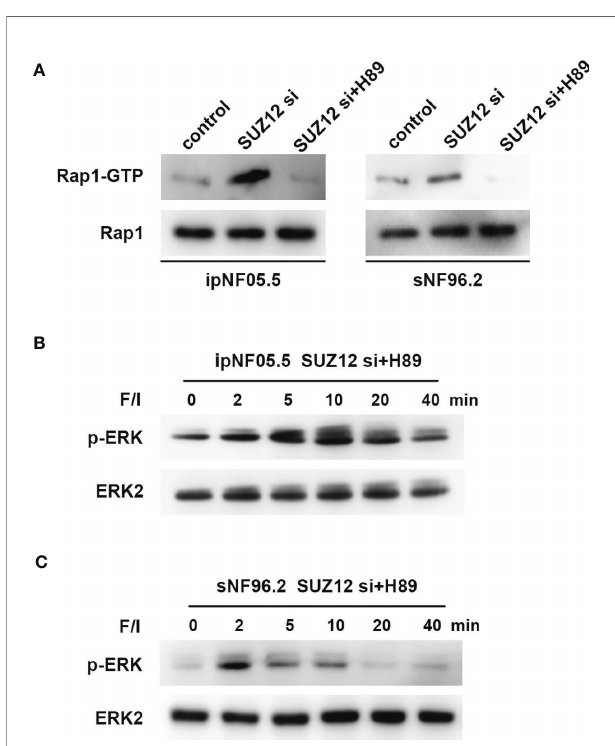
FIGURE 6 | Changes in Rap1-GTP and p-ERK after the addition of PKA inhibitor (H89). (A) Application of pull-down method to detect the effect of knockdown of SUZ12 and addition of H89 on the expression of Rap1-GTP, the activated form of Rap1. (B, C) Western blot showing the effect of H89 on the level of ERK phosphorylation in the SUZ12 si group treated with F/I in both ipNF05.5 and sNF96.2, and ERK2 was used as